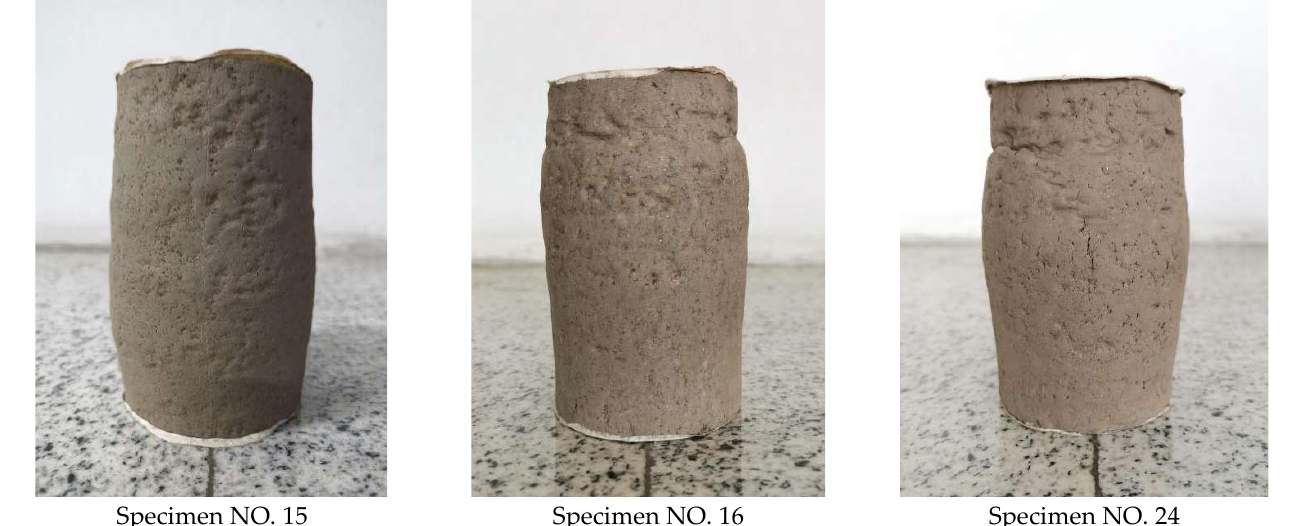
Figure 16. Appearances of tested specimens going through 11 FTHs.